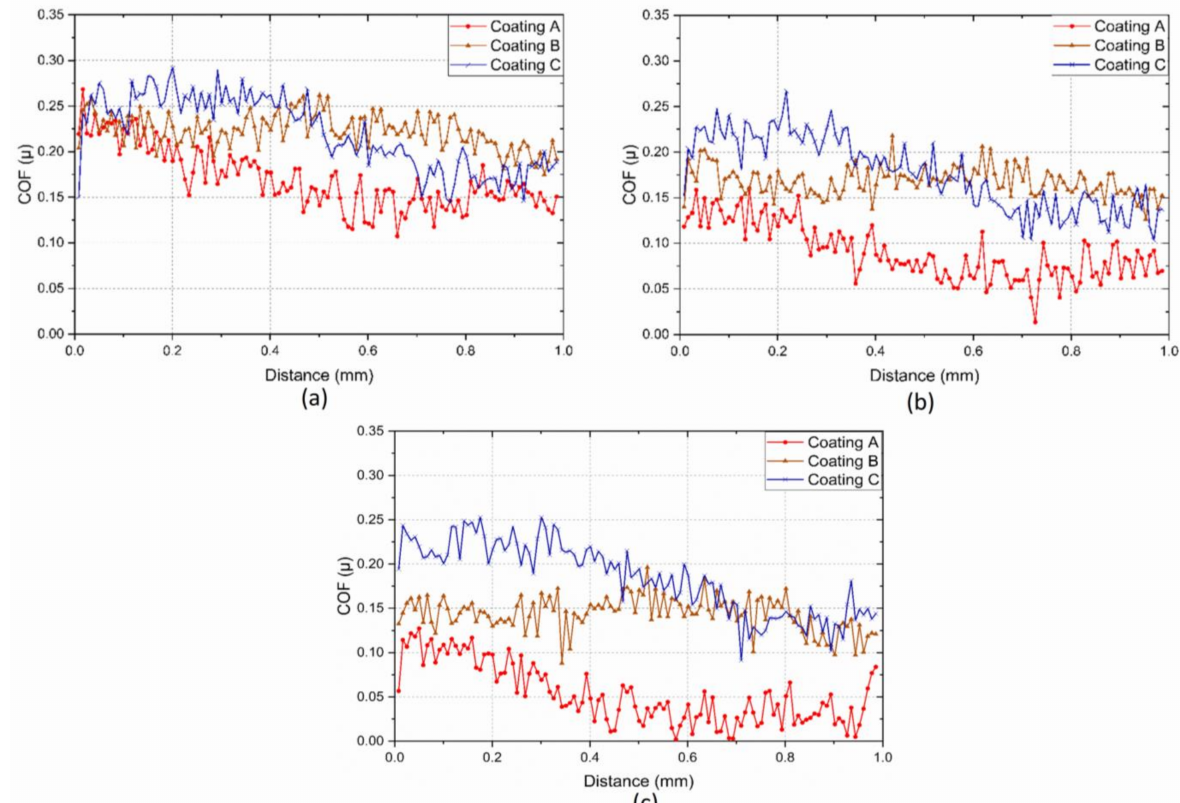
Figure 12. Ramped load scratch test data with optical images of the scratch track for Coating C.